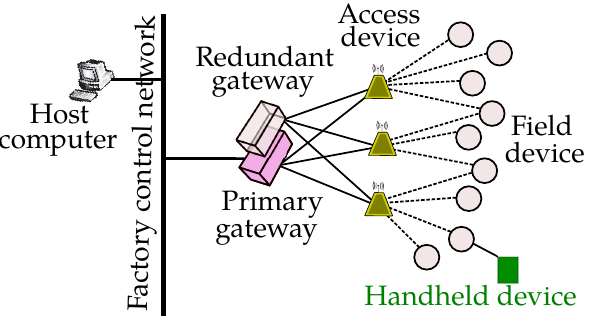
Figure 4. WIA-FA architecture (Redundant star topology)